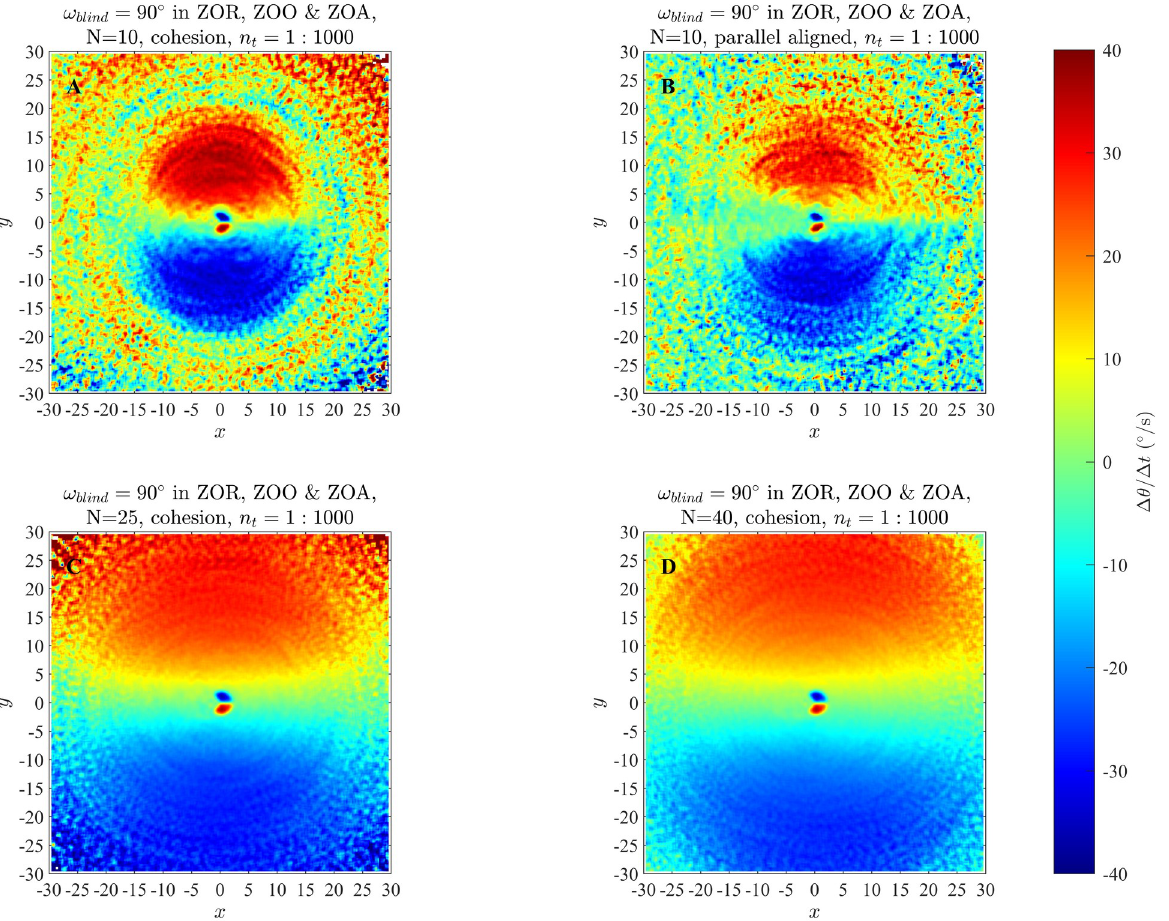
Fig 6. Changes in direction of motion of individuals as a function of the relative positions of partners obtained via analysis of simulations with r = 2, Δ r = 1, Δ r = 11 for groups of N = 10 (panels A and B), N = 25 (panel C), or N = 40 (D) individuals. Simulations were run for short r o a durations of 1000 time